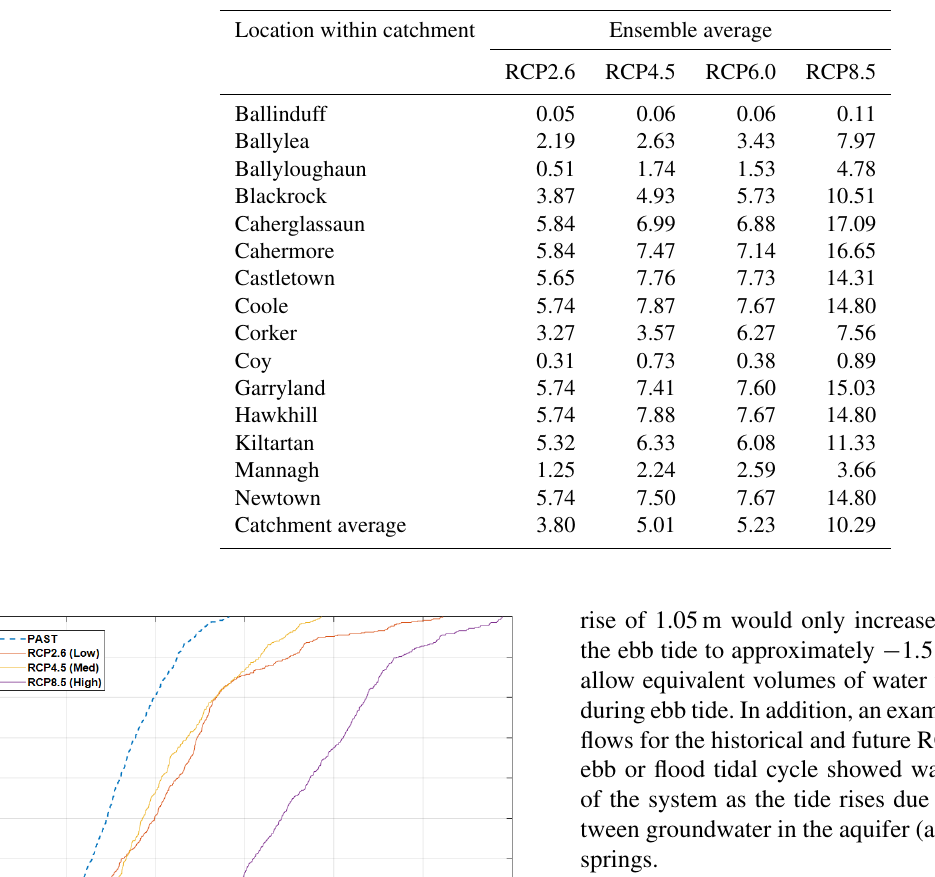
Table 5. Ensemble percentage change in 95th percentile flood levels for all RCM scenarios at all groundwater flood nodes within the South Galway karst model domain (a positive value indicates an increase in 95th percentile water level within the hydrological year).